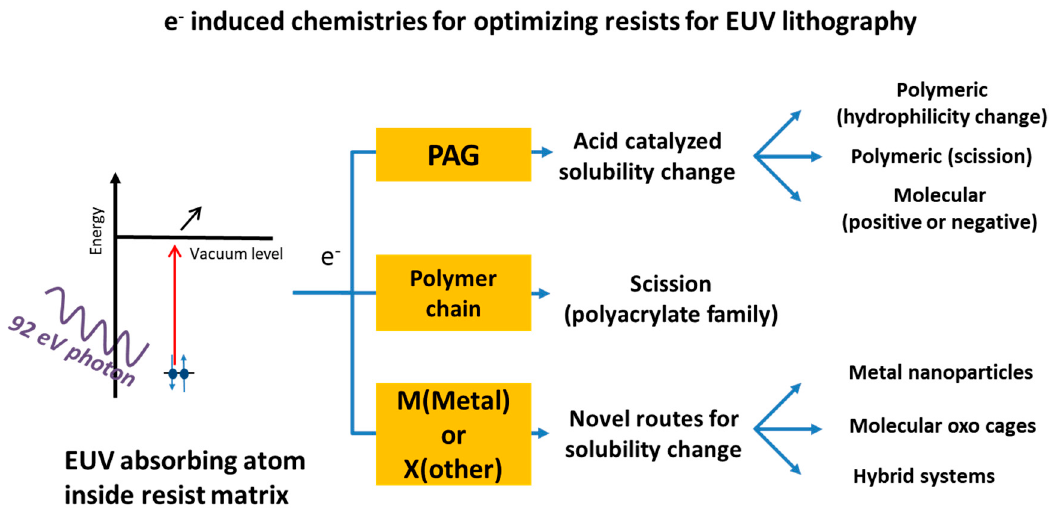
Figure 10. A summary of the most promising research directions that are currently explored toward high sensitivity and high performance EUV